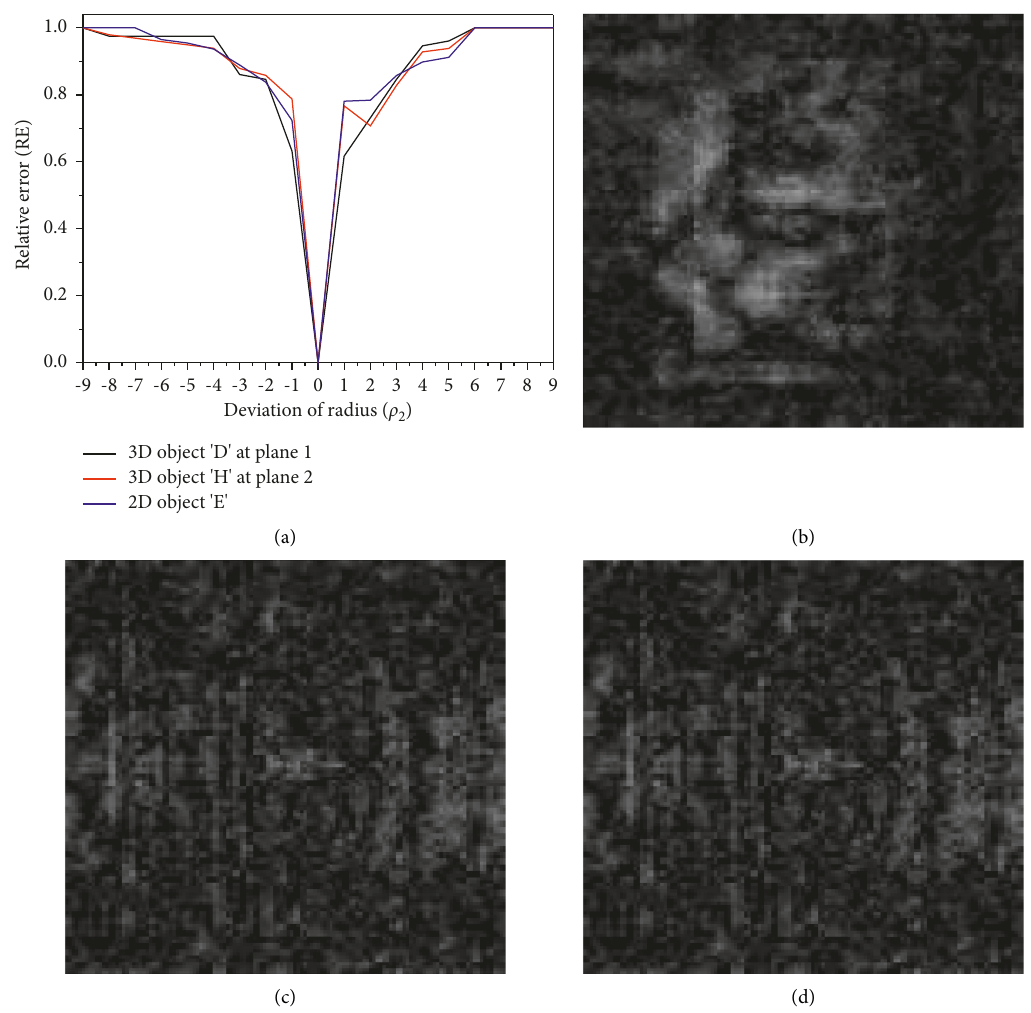
Figure 17: Decrypted results with wrong radius of Q object with incorrect radius ρ